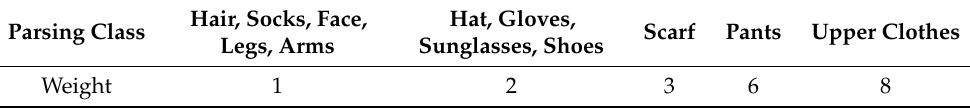
Table 2. Class w c weights determining the class importance in similarity score calculations. Hair, Socks, Face, Parsing Class Legs, Arms